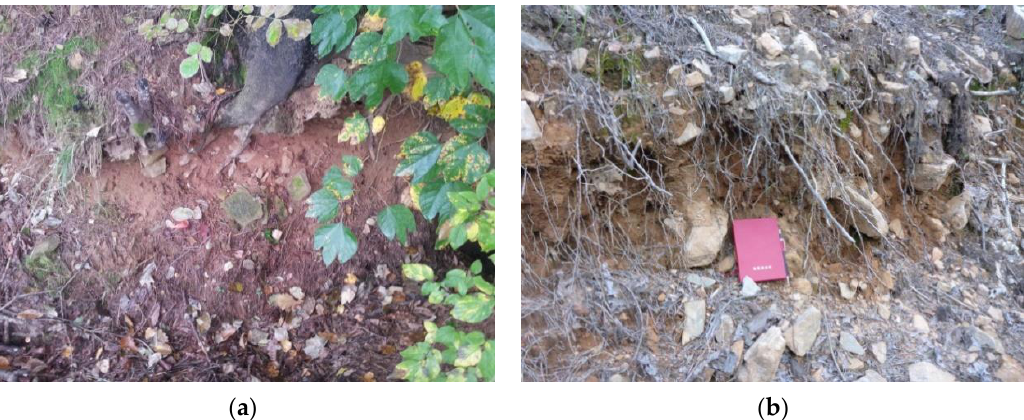
Figure 4. Residual colluvium at Mt Goobong. Size of the red note is 10 × 15 cm. ( a ) and ( b ) are in same scale.